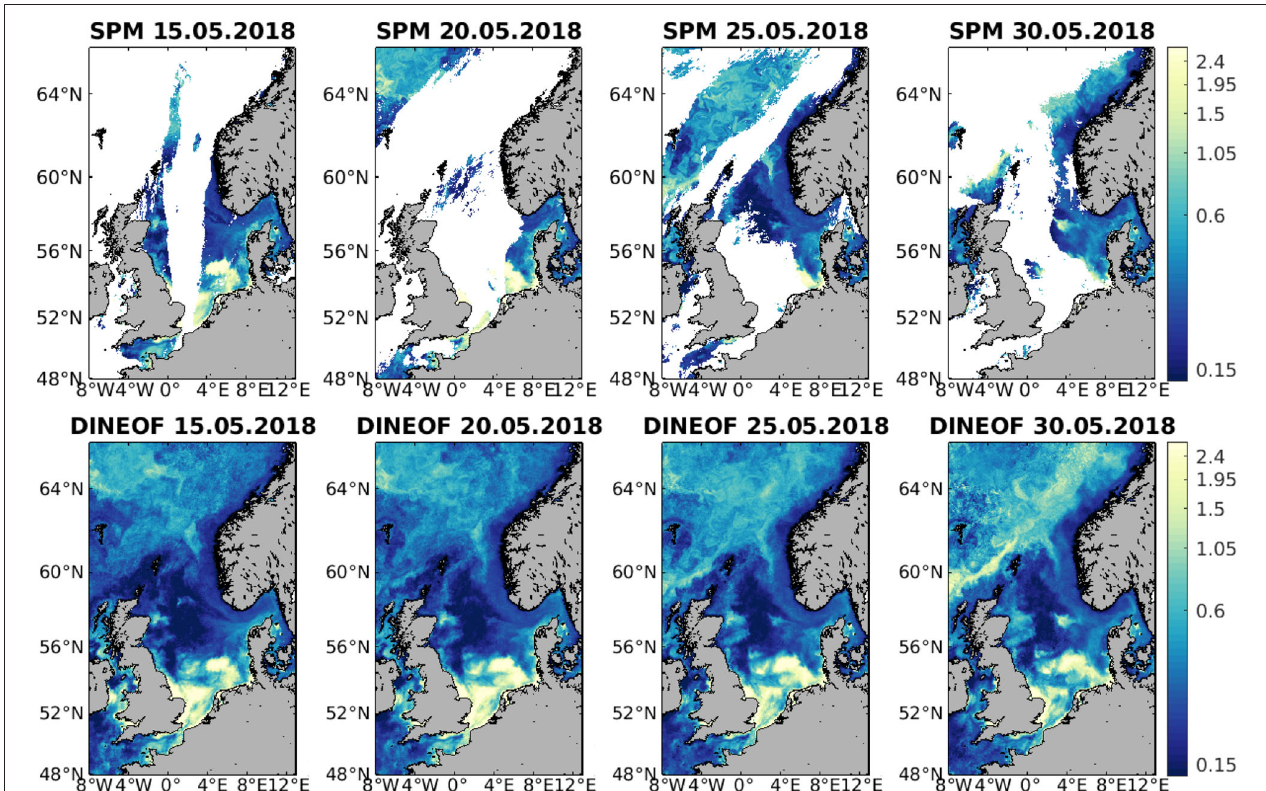
FIGURE 5 | Example of SPM ( mg / l ) on 15, 20, 25, and 30 May 2018 for the initial data (top) and corresponding DINEOF reconstruction (bottom)